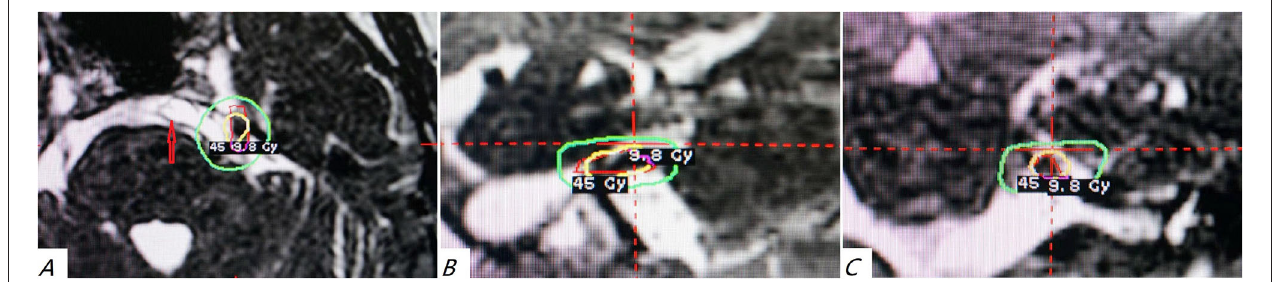
FIGURE 2 | The two-isocenter gamma knife irradiation on the trigeminal nerve of patients with VBD-TN is shown in the axial (A) , sagittal (B) , and coronal (C) positions, respectively. The red arrow shows the tortuous and dilated vertebrobasilar artery. The figure clearly shows the full length of the cisternal trigeminal nerve on the affected side and shows the 50% isodose line (45Gy, yellow circle) and the isodose line of 9.8Gy (green circle).